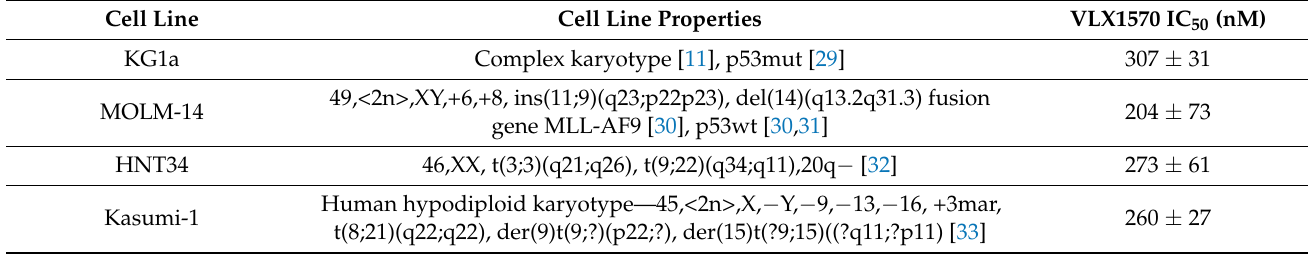
Table 3. AML cell lines used in the present study.